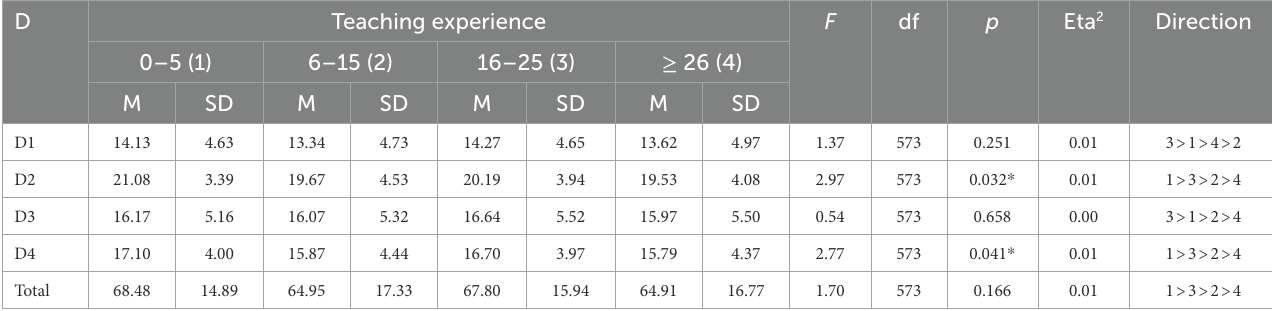
TABLE 6 ANOVA based on the teaching experience variable (years). D